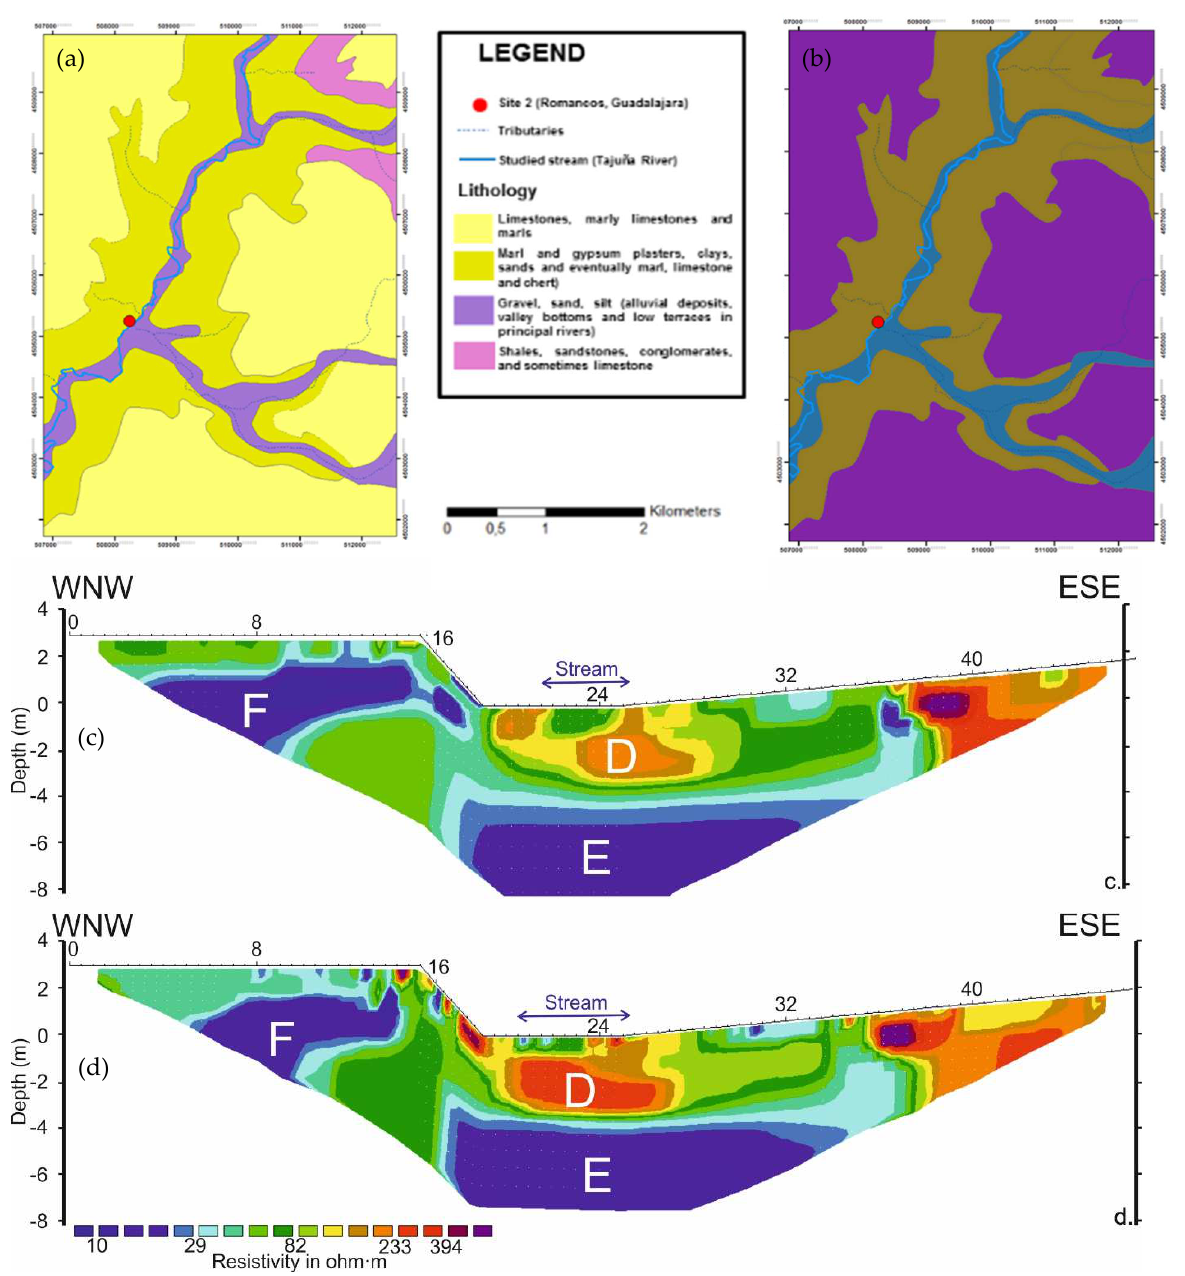
Figure 7. Characteristics of the of the hyporheic zone at Romanones, Tajuna River. ( a ) lithology; ( b ) permeability; ( c ) ERT applied in June 2013; ( d ) ERT applied in April 2014.